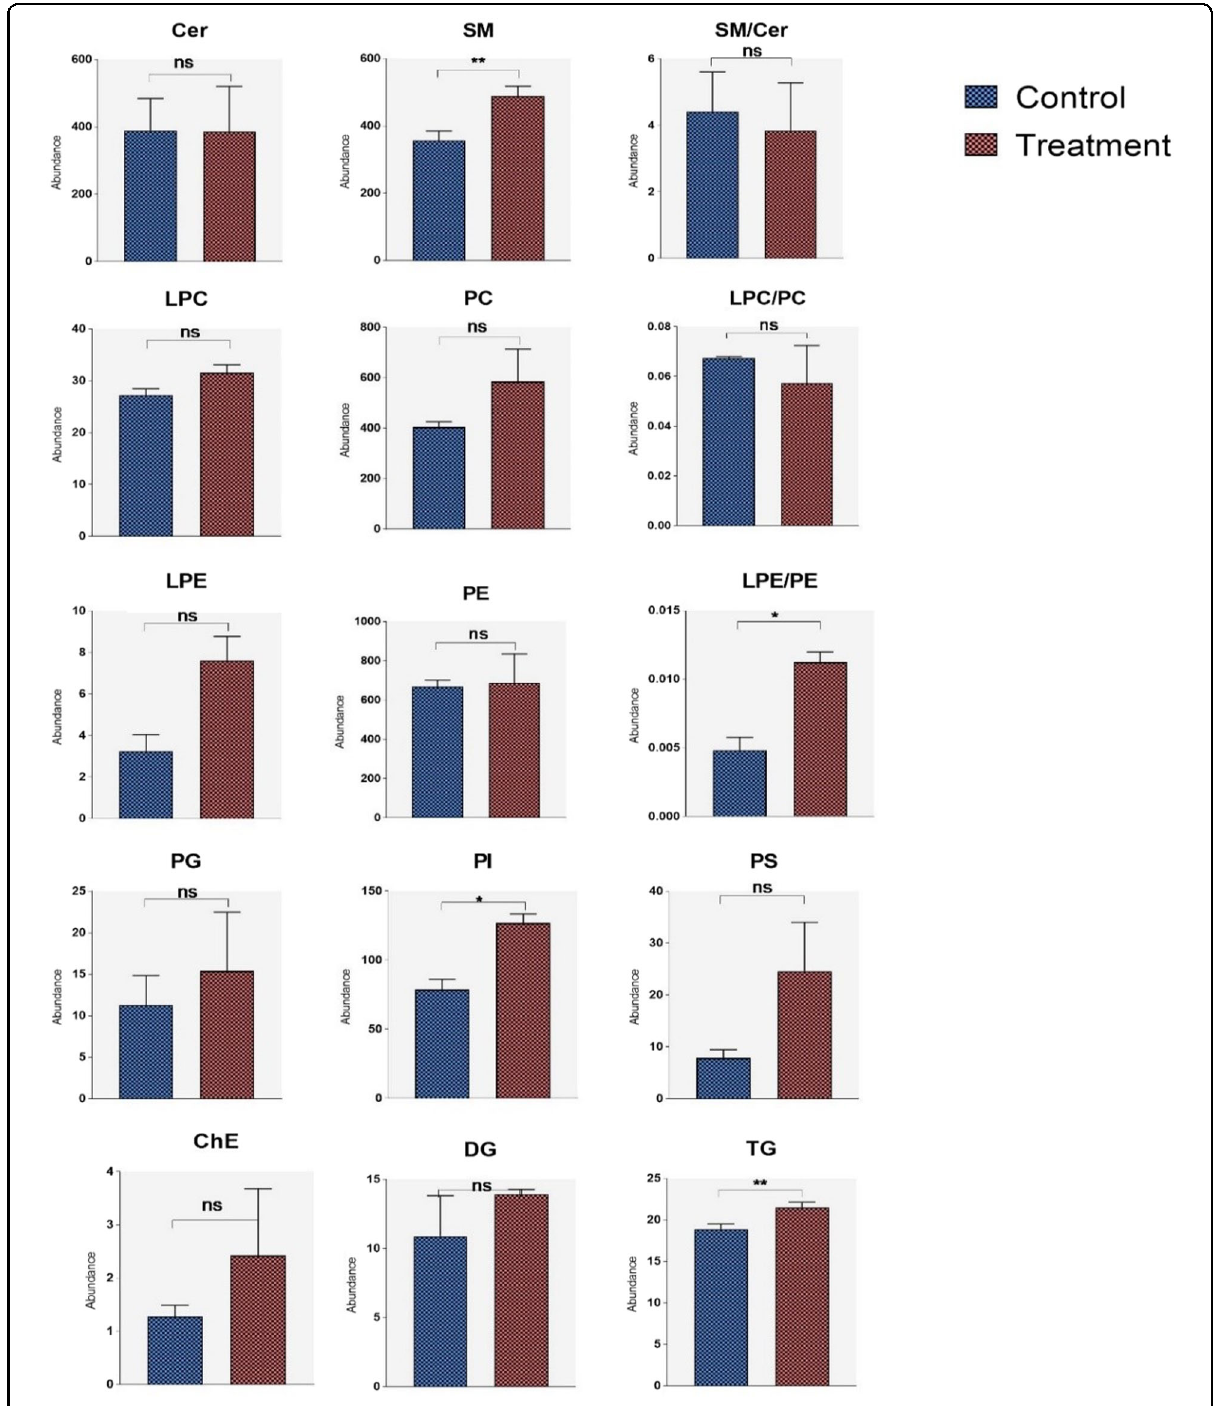
Fig. 4 Normalized lipid group abundance in amyloid beta-treated astrocytes versus controls. Cer ceramides, SM sphingomyelins, ChE Cholesteryl esters, DG diglycerides, TG triglycerides, PC phosphatidylcholines, LPC lyso-phosphatidylcholines, PE phosphatidylethanolamines, PI phosphatidylinositols. T tests were used to compare lipids between two groups. ns: no signi fi cance, * p < 0.05, ** p <